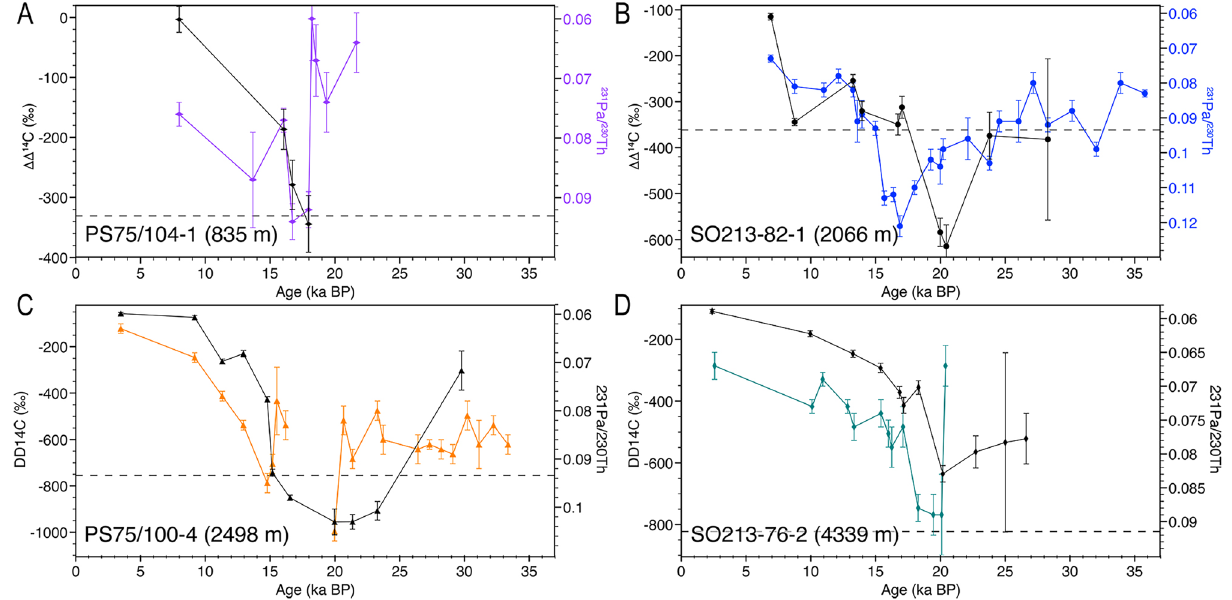
Figure 5. Comparison of 231 Pa/ 230 Th-data (this study) to published radiocarbon records, measured on the— same sediment cores 10,56 . Colors as indicated in Fig. 1. Black lines—ΔΔ 14 C; Please note that some additional 14 C-data were added for SO213-82-1 ( A ) as indicated in Table S2. The dashed lines indicate the 231 Pa/ 230 Th production